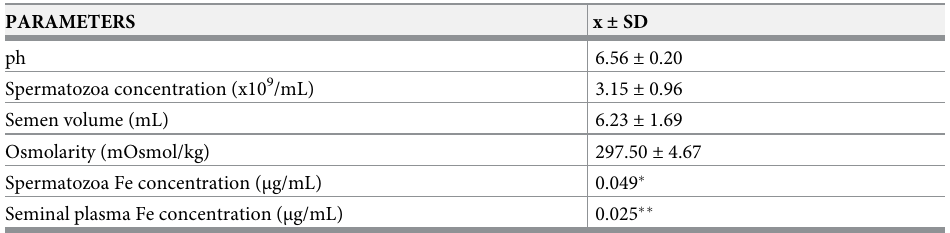
Table 1. The basic parameters of bovine semen samples (n =